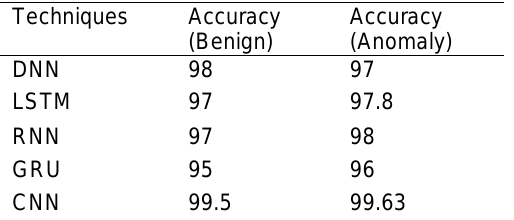
Table 2. Accuracy according to the Class